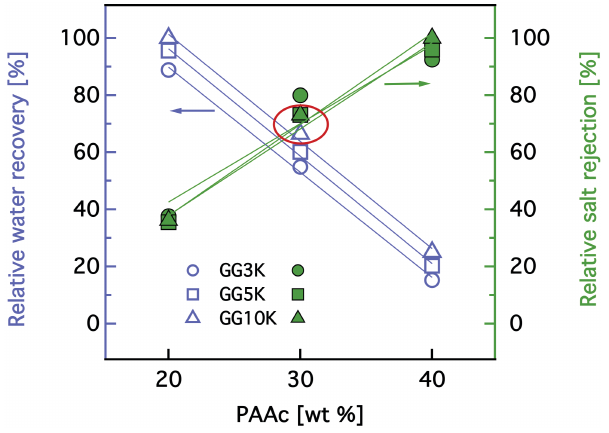
Figure 15. Overview of the performance of hydrogels in terms of desalinated water recovery and salt rejection as a function of grafted PAAc content. The straight lines are linear